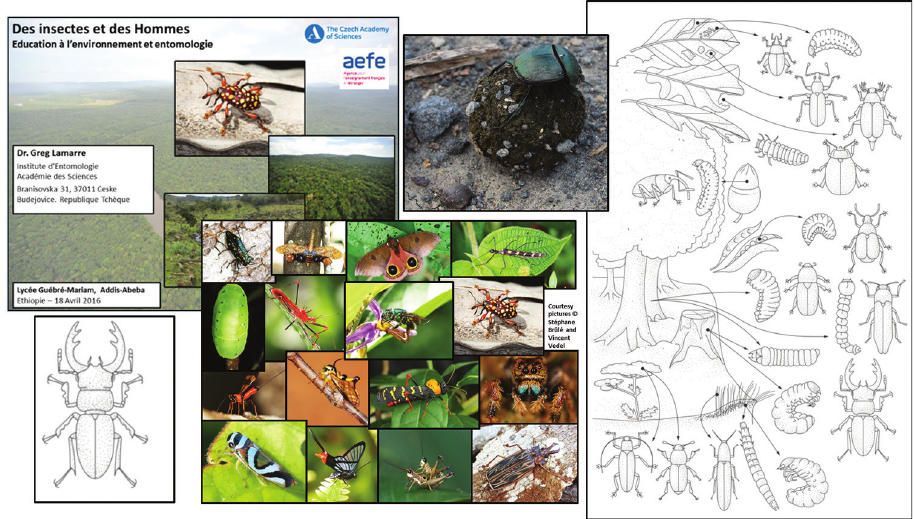
Figure 1. Slide, plates and pictures used for the teaching of the role of insect in global diversity and ecosystem functioning (Seq#1). It includes the PowerPoint presentation for lectures; an illustration of a dung beetle to pre- sent their crucial role as soil engineers; an illustrated plate of the multiple arthropods observed in tropical rain- forests and finally the myriad insects inhabiting one unique tree associated with different niches (Evans,